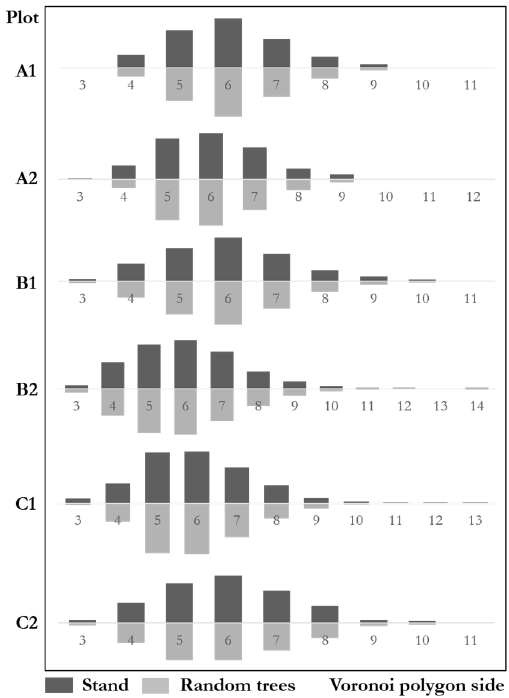
Figure 9. Voronoi polygon side distributions of stands and random trees.